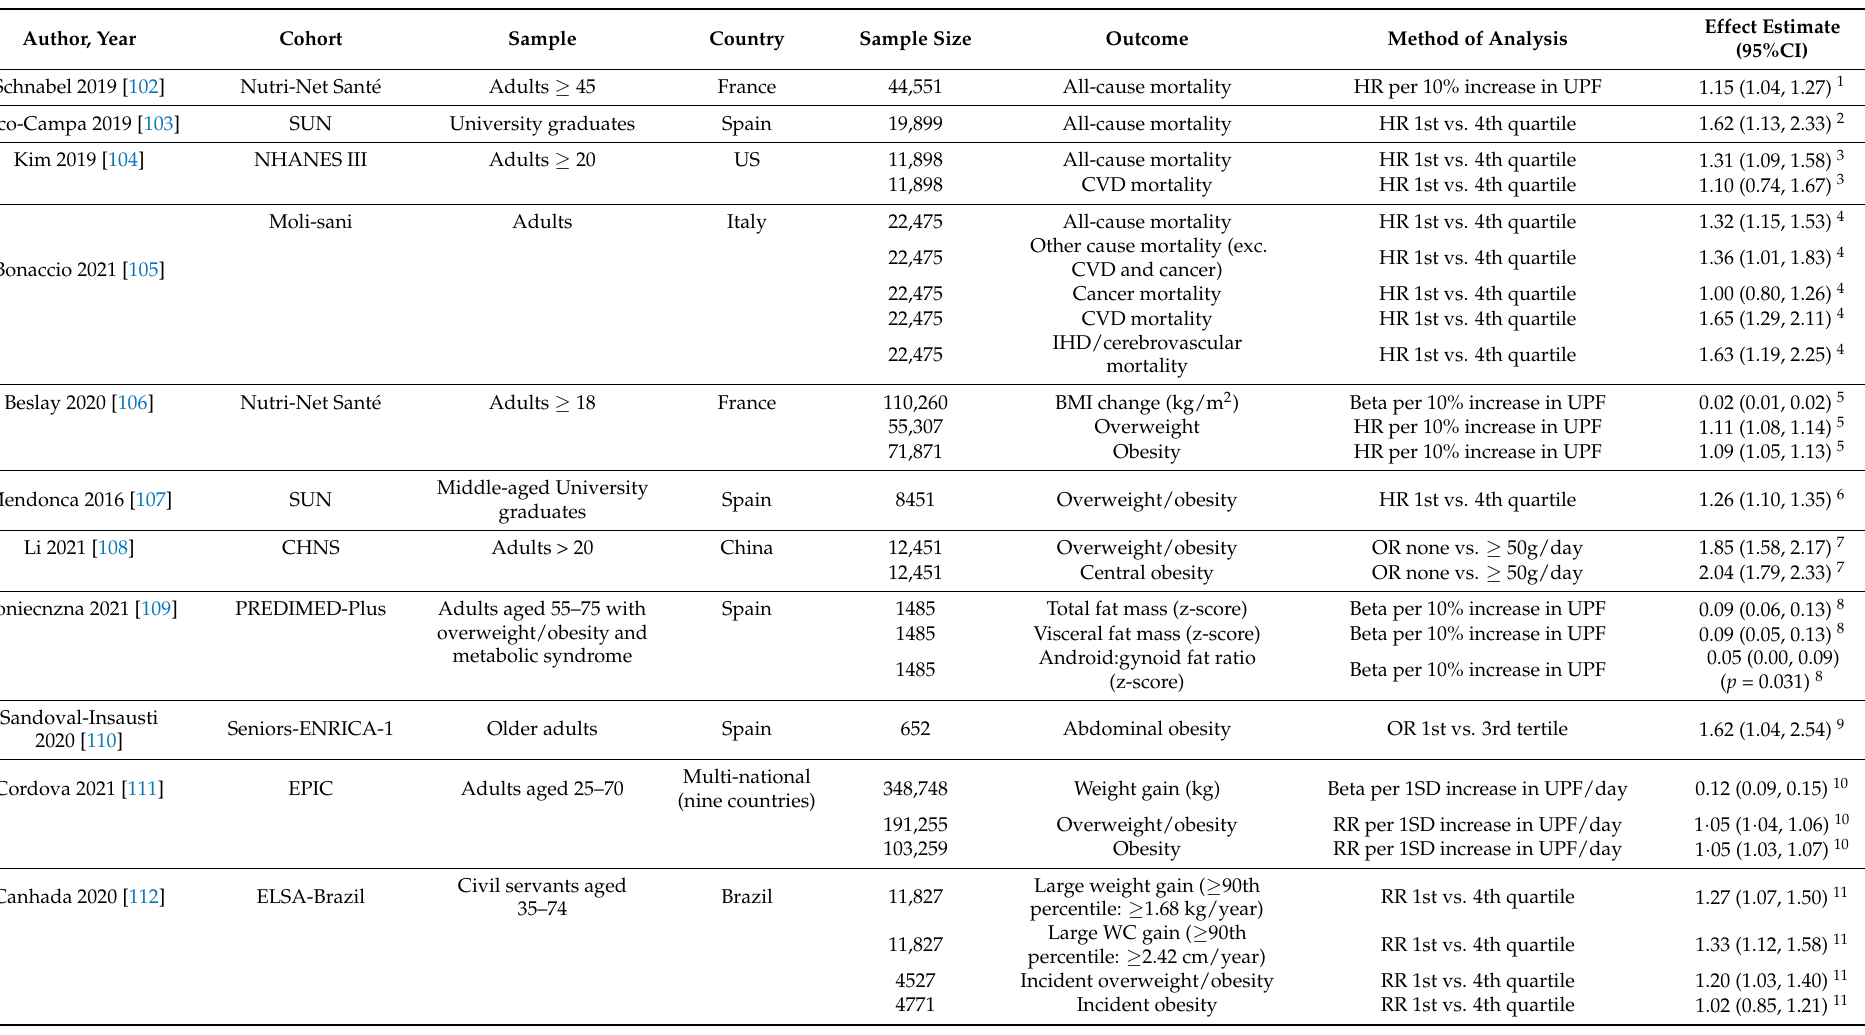
Table 2. Characteristics of prospective studies assessing the association between UPF intake and health-related outcomes whilst also reporting dietary